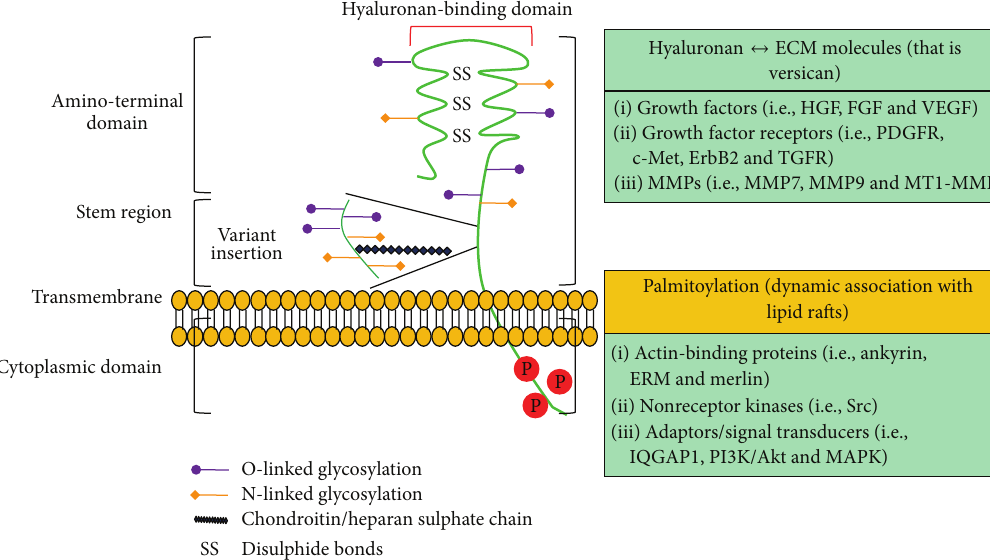
Figure 5: Structure, binding domains, and interactions of CD44 (Adapted from [7]). The ectodomain of CD44 contains HA-binding motifs and can contain chondroitin sulfate or heparan sulfate chains that can affect its HA-binding capacity and enable its interactions with growth factors and growth factor receptors, and its interaction with matrix metalloproteinases (MMPs). Transmembrane and cytoplasmic domains undergomultipleposttranslationalmodifications,includingpalmitoylationandphosphorylationoncysteineandserineresidues,respectively, promoting the binding of proteins with crucial functions in cytoskeletal organization and signaling. ErbB2: epidermal growth factor receptor- 2; ERM: ezrin–radixin–moesin; FGF: fibroblast growth factor; HGF: hepatocyte growth factor; IQGAP1: IQ motif containing GTPase activating protein 1; MAPK: mitogen-activated protein kinase; PDGFR: platelet-derived growth factor receptor; PI3K: phosphoinositide 3- kinase; TGFR: transforming growth factor receptor; VEGF: vascular endothelial growth